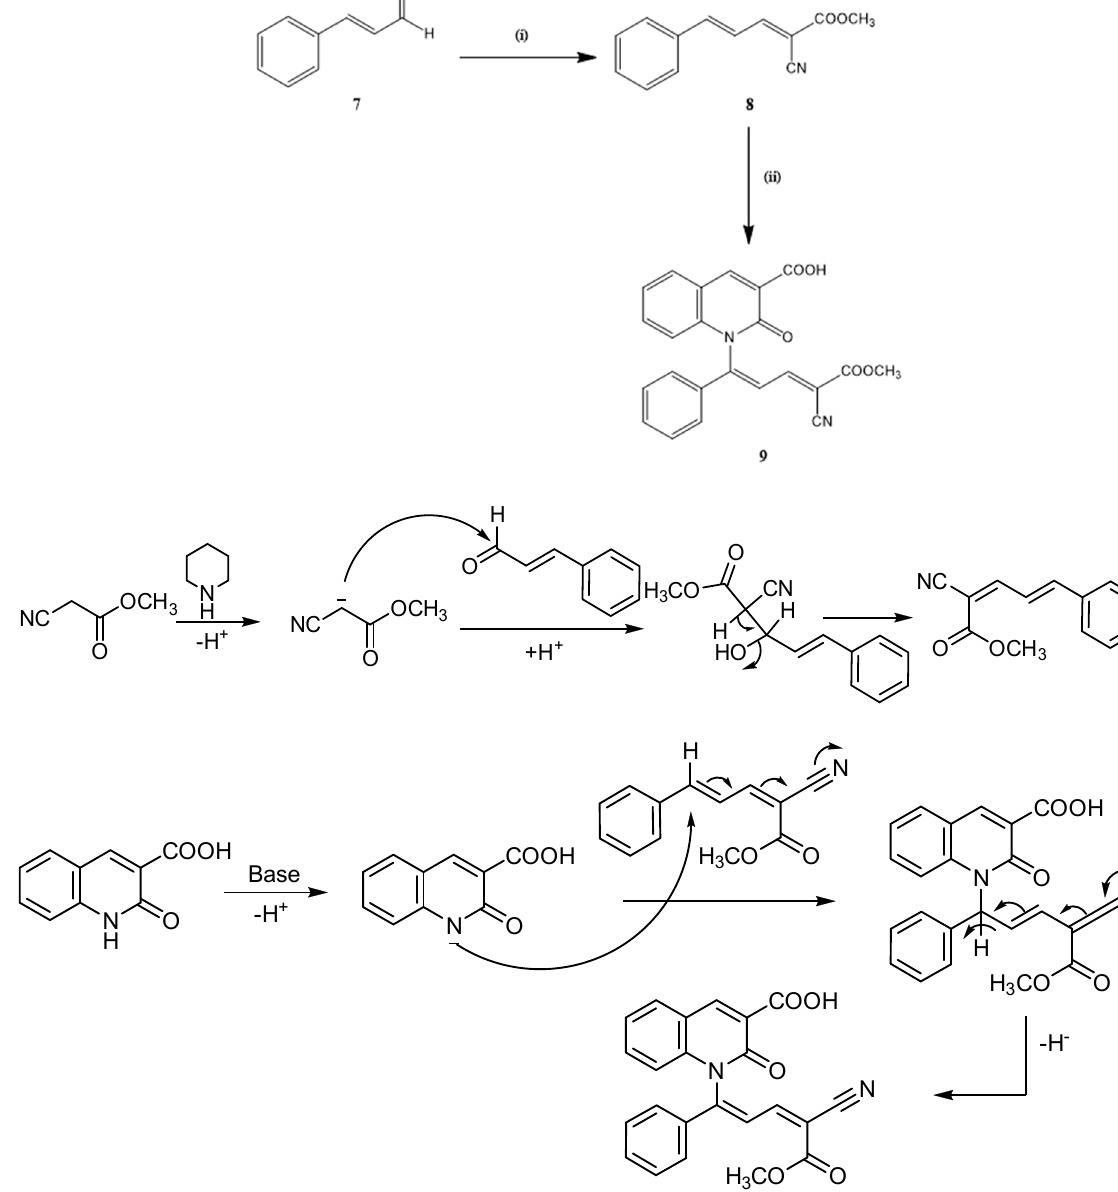
Scheme 3. Synthesis of 1- N -(4-cyano-5-methoxy-5-oxo-1-phenylpenta-b3-diene-l-y1)- azacoumarin-3-carboxylic acid ( 9 ). Reagents and reaction conditions: (i) methyl cyanoacetate, piperidine/MeOH; (ii) 1- N - azacoumarin-3-carboxylic acid, Et 3 N/DMF.